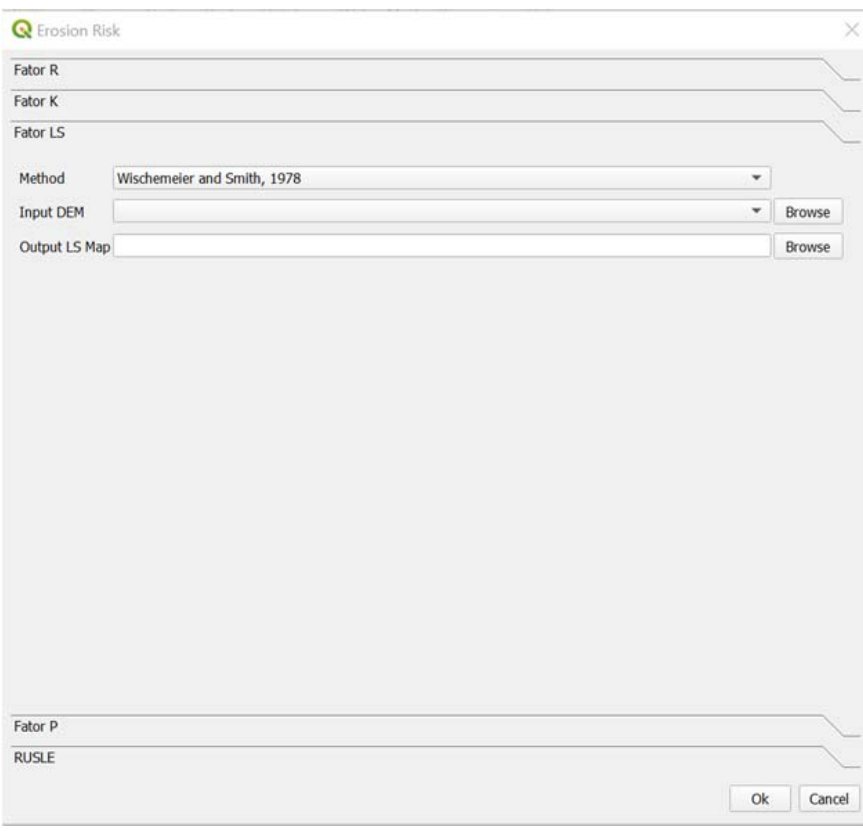
Figure 1. Erosion Risk main window (LS factor).